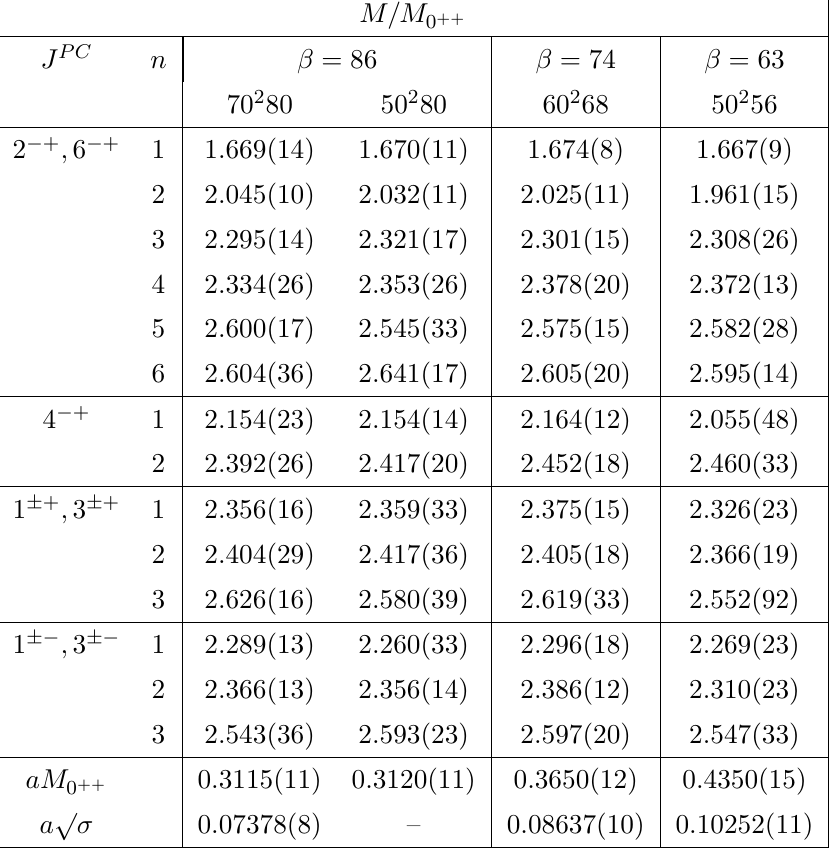
Table 19. Some mass ratios using conventional operators. To test for (cid:12)nite volume and lattice spacing corrections. Last two rows list the mass gap and the square root of the string tension.